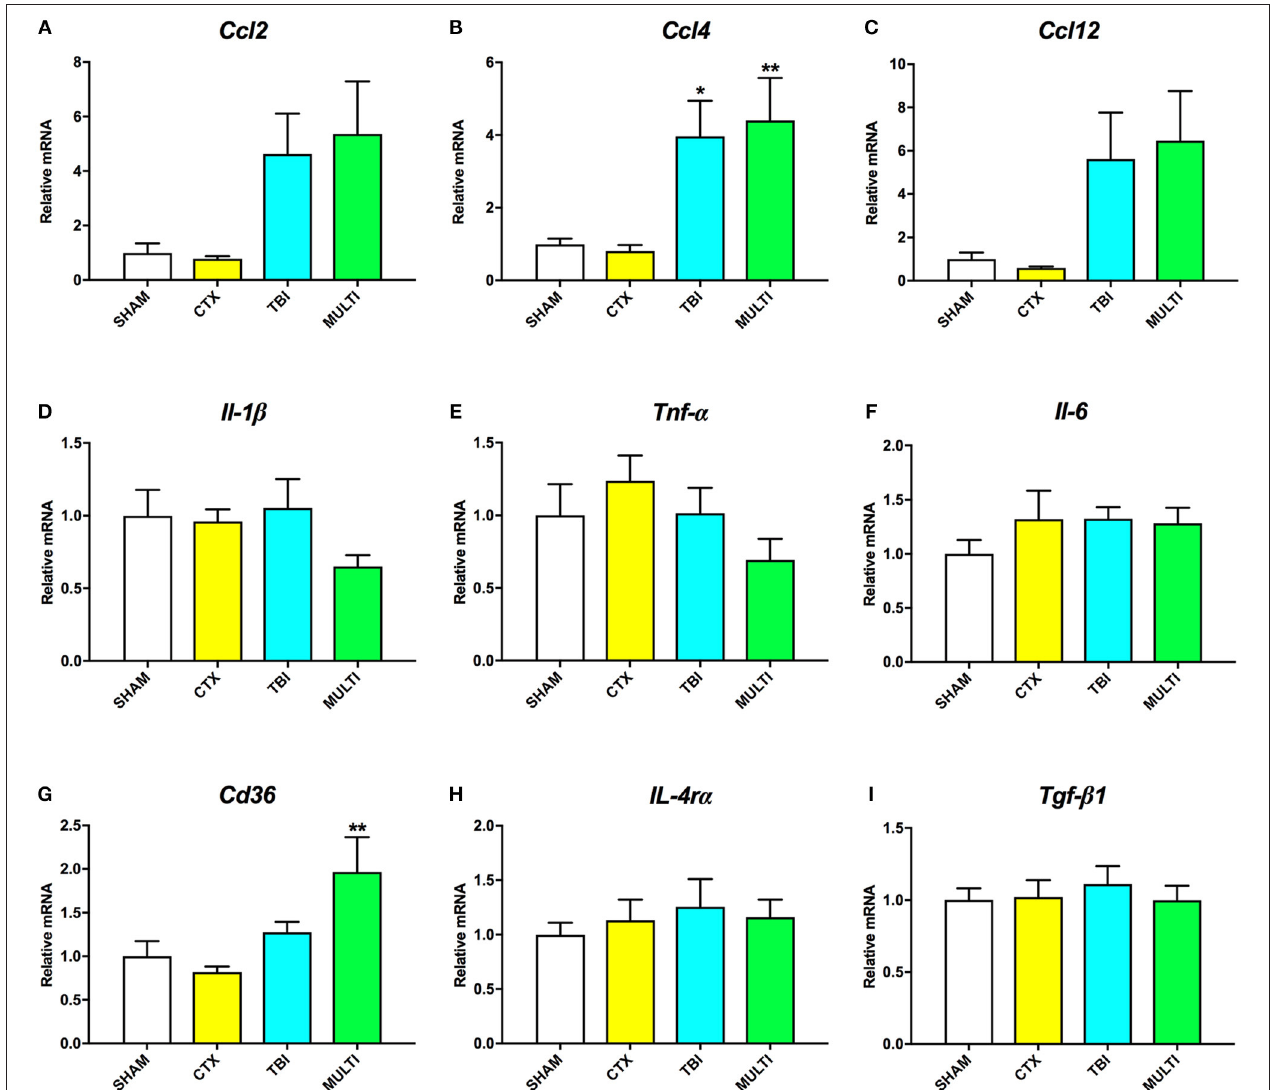
FIGURE 4 | mRNA levels of pro- (A–F) and anti-inflammatory (G–I) cytokines in the ipsilateral cortex at 24h post-injury. There was a significant effect of injury on Ccl 2 (A) and Ccl 12 (C) . Although TBI and MULTI groups appeared to have similarly elevated levels of Ccl 2 and Ccl 12, post-hoc analyses did not reach statistical significance after Bonferroni corrections. (B) Both the TBI and MULTI groups had significantly increased Ccl 4 mRNA levels compared to the CTX group, and that the MULTI group was also significantly higher than the SHAM group. (G) The MULTI group had significantly higher mRNA levels of Cd 36 than both the CTX and SHAM groups. There were no significant differences on mRNA levels of Il-1 β (D) , Tnf- α (E) , Il-6 (F) , Il-4r α (H) , or Tgf- β 1 (I) . *different than CTX; **different than SHAM and CTX; p < 0.05. See Results for additional